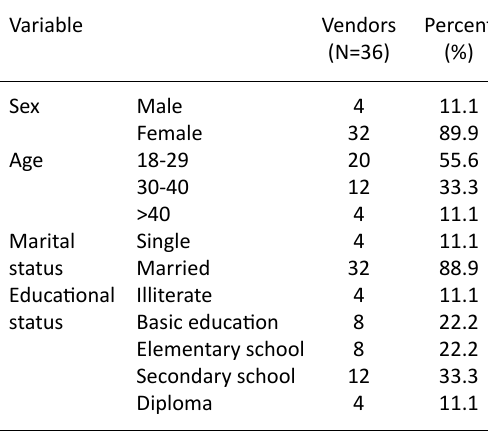
Table 1. Socio-demographic profile of food sellers